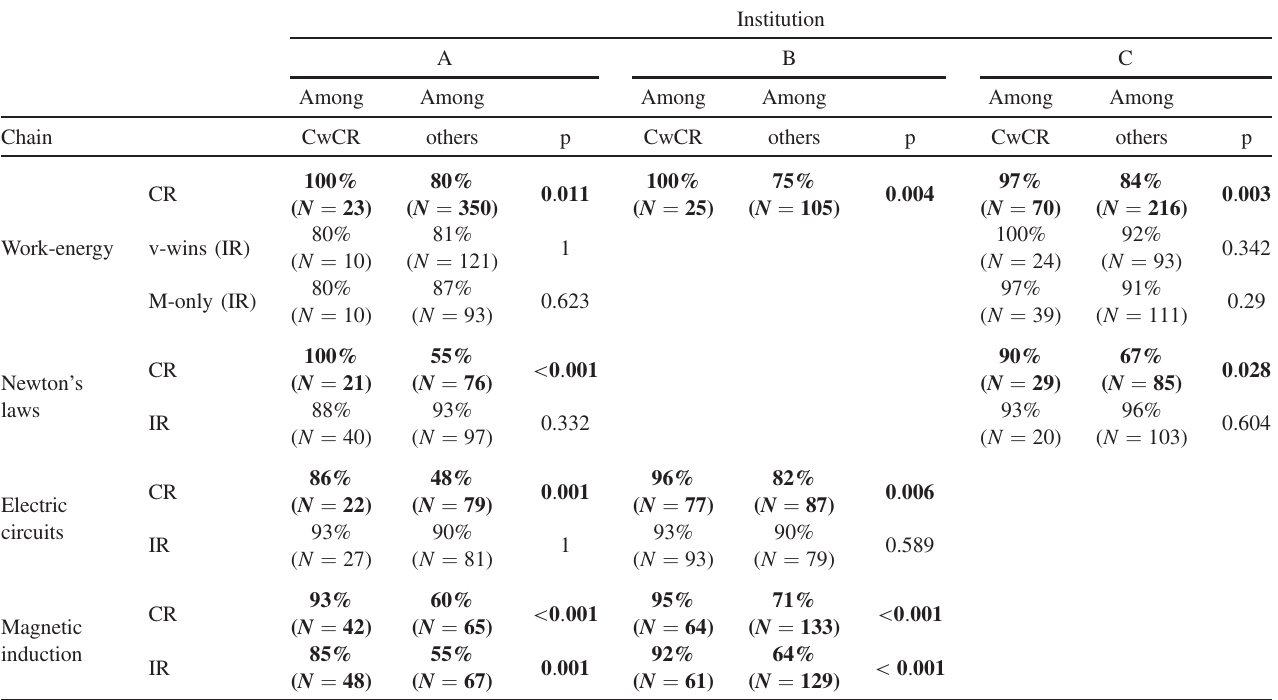
TABLE III. Student ability to follow each reasoning chain, broken out by performance on the base task. “ CR ” and “ IR ” refer to correct and incorrect reasoning chains, respectively. In some cases, data from multiple semesters and lecture sections have been combined. P values were calculated using Fisher ’ s exact test to test whether students who had given a correct answer and provided correct reasoning (CwCR) were more likely to follow the reasoning chain correctly than other students. The “ other ” group includes both students who had given an incorrect answer on the base task as well as those who had given a correct answer on the base task but had provided an incorrect justification. Statistically significant differences are indicated in